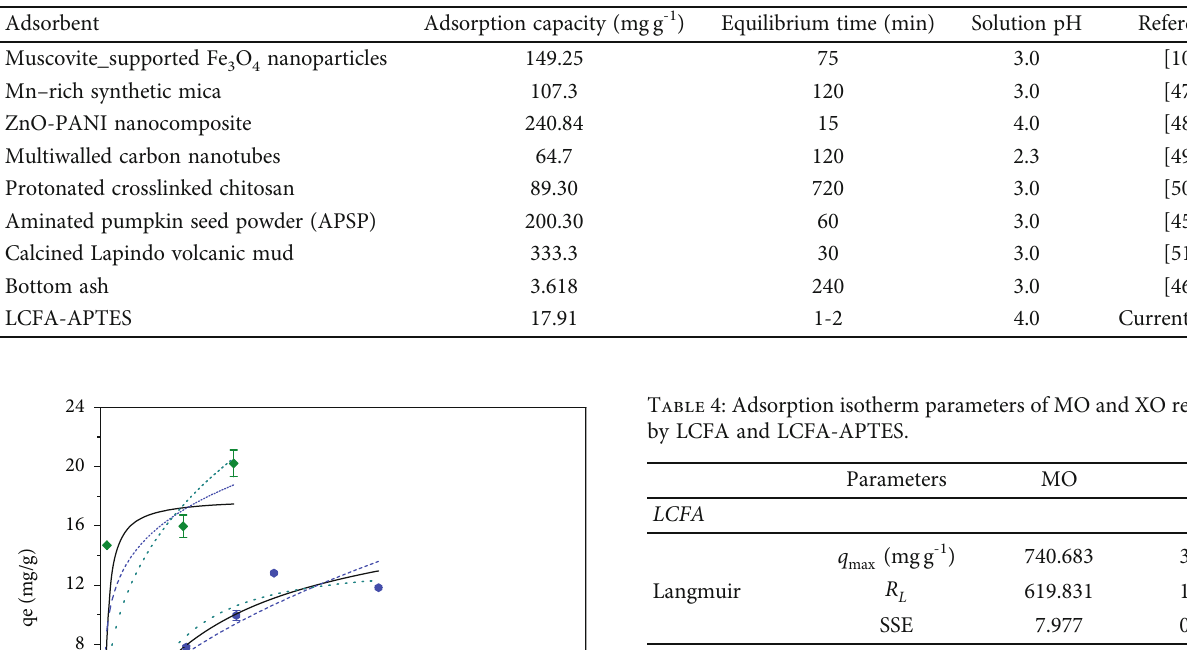
Table 3: Performance evaluation of LCFA-APTES with aforementioned adsorbents for MO dye adsorption as a function of maximum adsorption capacity, equilibrium time, and medium